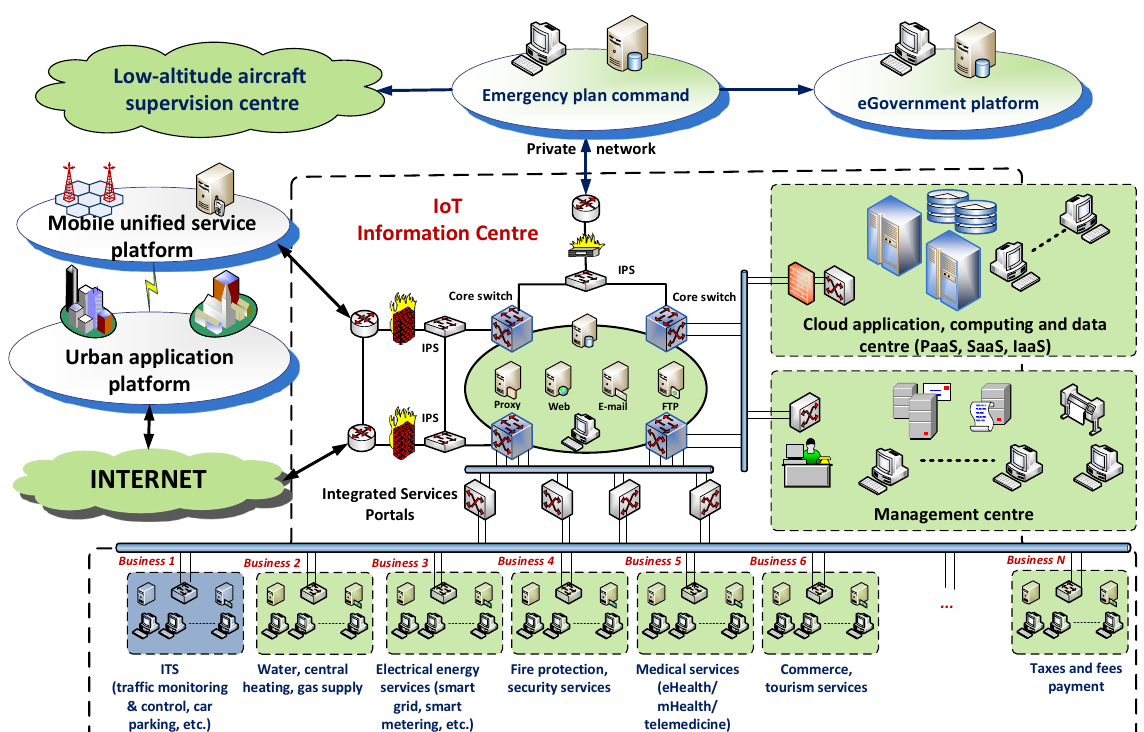
Figure 3. A high-level view of an IoT-based Smart City.